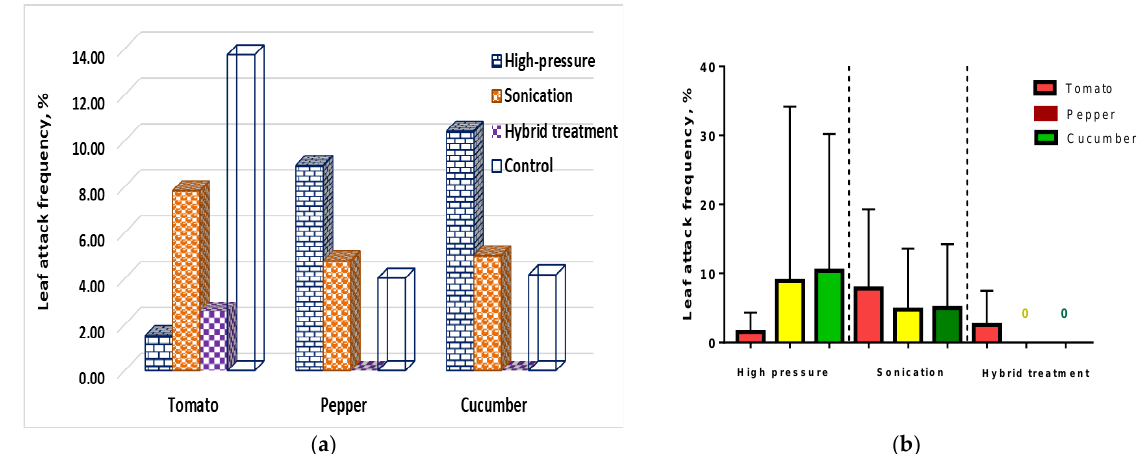
Figure 13. The influence of treatments on the pest attack reduction: ( a ) leaf attack frequency and ( b ) statistical evaluation.